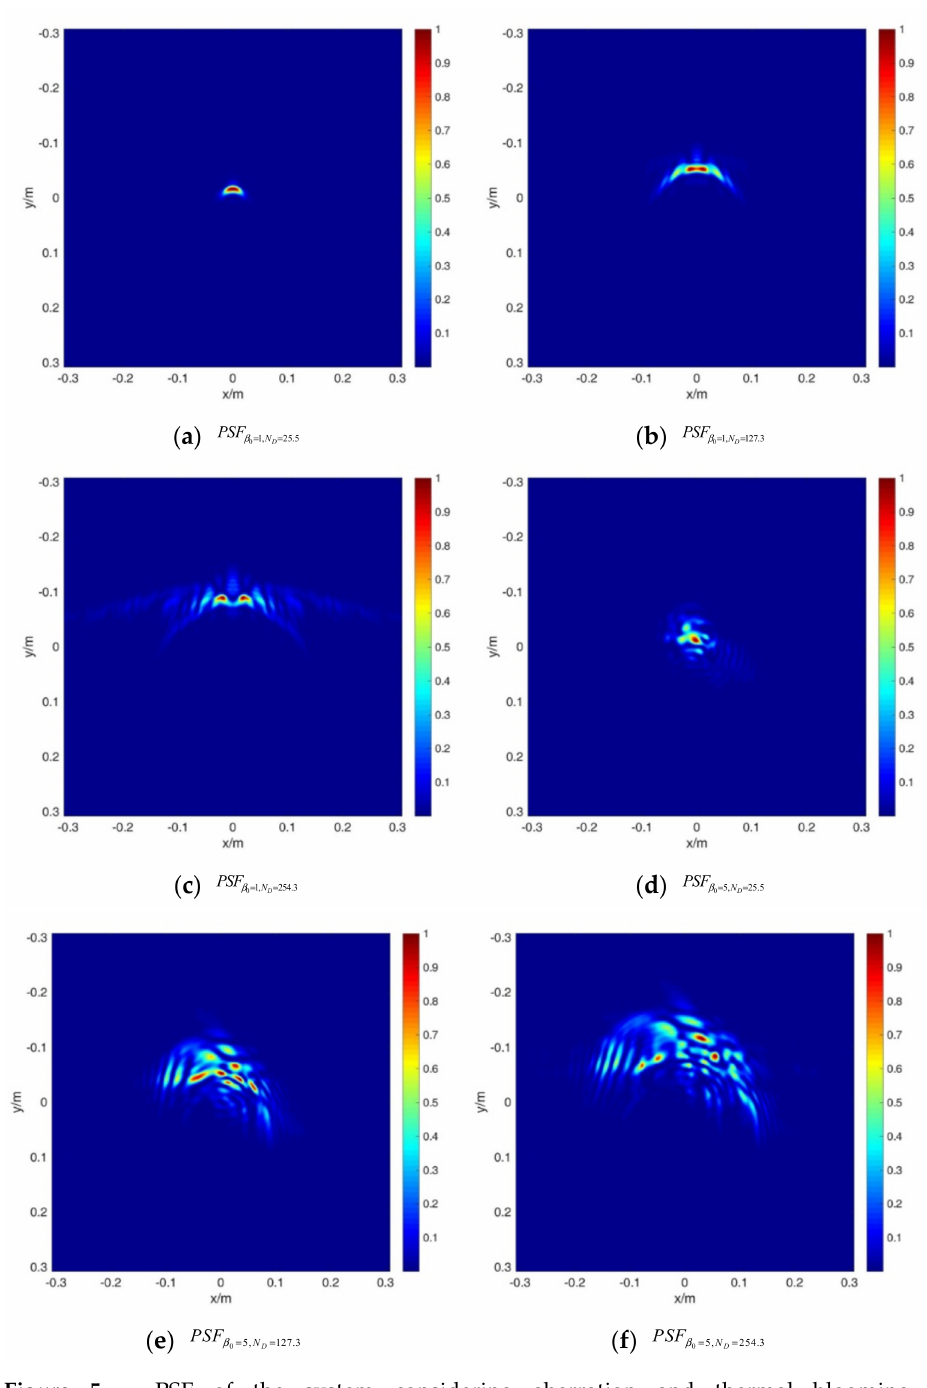
Figure 5. PSF of the system considering aberration and thermal blooming effect for ( a ) PSF β , ( b ) PSF β , ( c ) PSF β , ( d ) PSF β , 0 = 1, N D = 25.5 0 = 1, N D = 127.3 0 = 1, N D = 254.3 0 = 5, N D = 25.5 ( e ) PSF β , and ( f ) PSF β 0 = 5, N D = 127.3 0 = 5, N D = 254.3